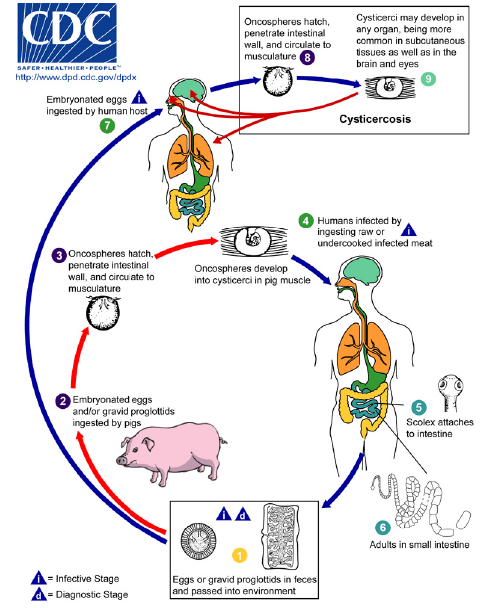
Figure 1. Life cycle of Taeniasolium cysticercosis (source: CDC- DPDx). Cysticercosis is an infection of both humans and pigs with the larval stages of the parasitic cestode, Taenia solium . This infection is caused by ingestion of eggs shed in the feces of a human tapeworm carrier (1). Pigs and humans become infected by ingesting eggs or gravid proglottids (2), (7). Humans are infected either by ingestion of food contaminated with feces, or by autoinfection. In the latter case, a human infected with adult T. solium can ingest eggs produced by that tapeworm, either through fecal contamination or, possibly, from proglottids carried into the stomach by reverse peristalsis. Once eggs are ingested, oncospheres hatch in the intestine (3), (8) invade the intestinal wall, and migrate to striated muscles, as well as the brain, liver, and other tissues, where they develop into cysticerci (9). In humans, cysts can cause serious sequellae if they localize in the brain, resulting in neurocysticercosis. The parasite life cycle is completed, resulting in human tapeworm infection, when humans ingest under- cooked pork containing cysticerci (4). Cysts evaginate and attach to the small intestine by their scolex (5). Adult tapeworms develop, (up to 2 to 7 m in length and produce less than 1000 proglottids, each with approximately 50,000 eggs) and reside in the small intestine for